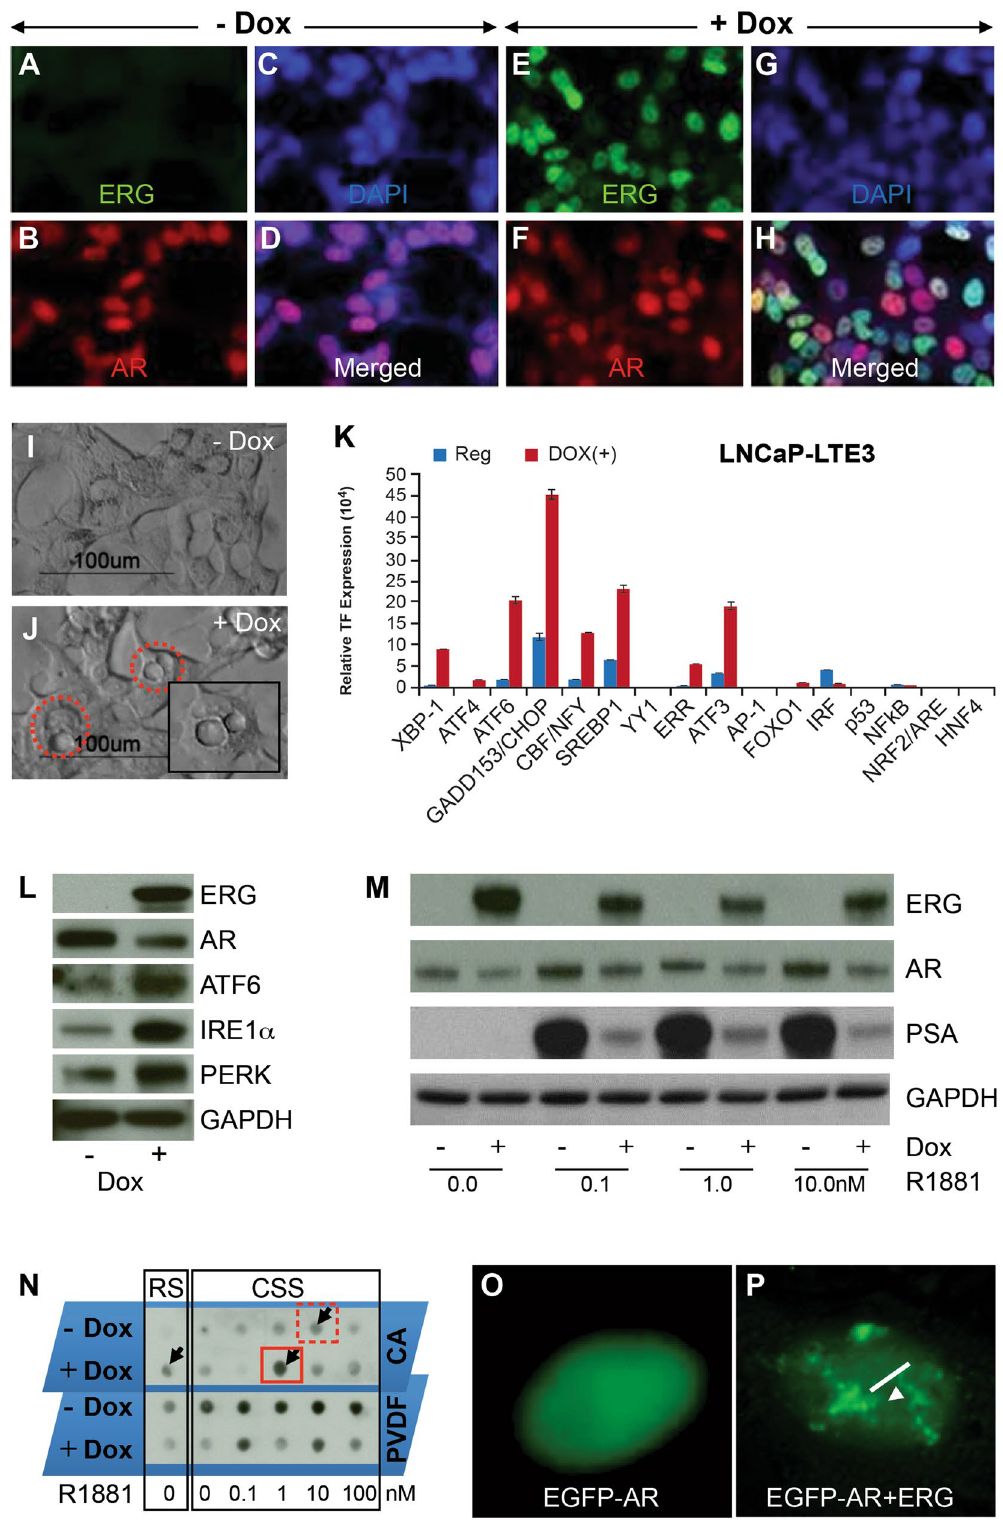
Figure 6. ERG induces ER stress and AR aggregation in LNCaP cells. Stable and doxycycline inducible ERG expressing LNCaP-Ln TE3 cells were generated by lentiviral expression vector and characterized by immunofluorescence using mouse monoclonal ERG antibodies (9FY) and anti-AR antibodies ( A–H ). ERG expression was detected upon induction with 1 ug/ml of doxycycline treatment for 24 hrs. Note the ERG expression in un-induced ( A ) and induced ( B ). Increased numbers of vacuole formations (red dotted circles) were observed with doxycycline induction of ERG ( J and Supplementary Figure S7). Analysis of the ER stress transcription factors was analyzed in LNCaP-Ln TE3 cell lysates prepared from without and with induction